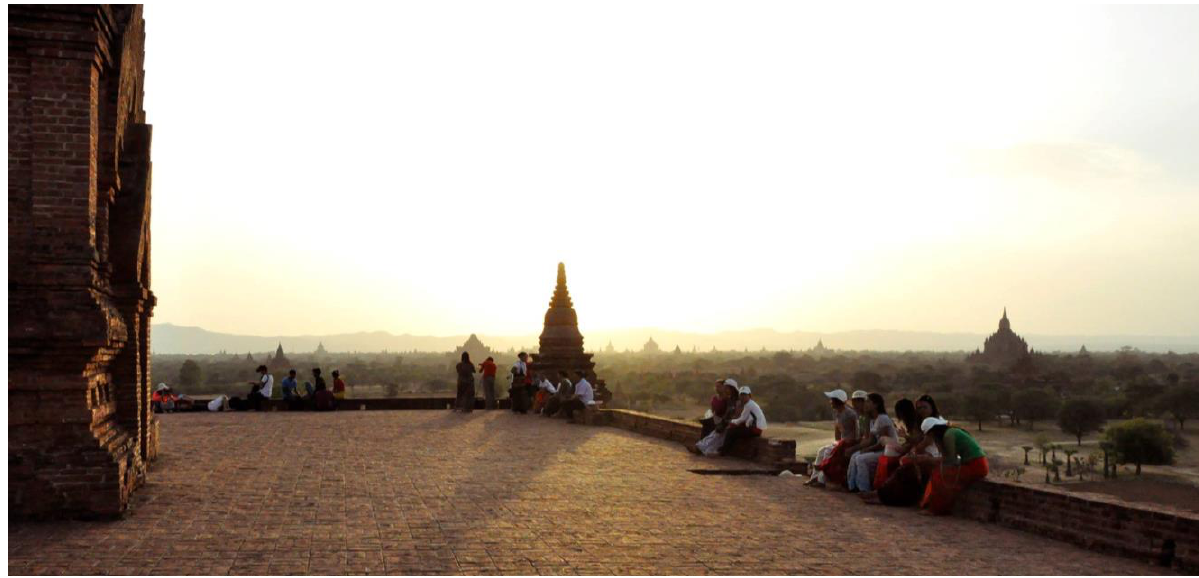
Figure 1 The plain of Bagan, Myanmar. Image source: Lori